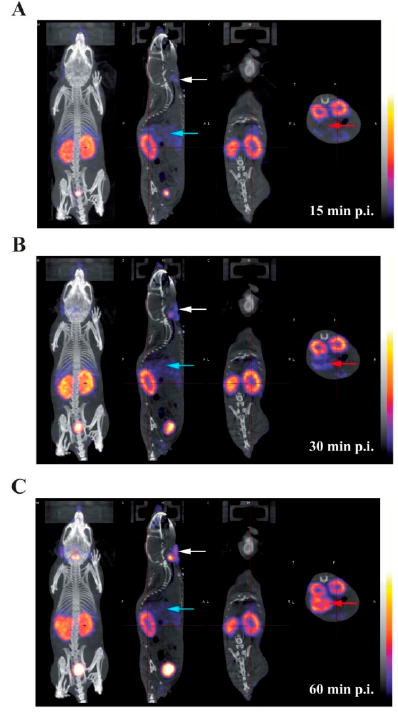
Figure 4. Whole-body SPECT/CT in vivo imaging of 125 I-Tyr-MCa in CD-1 mice at 15 min post-injection ( A ); 30 min post-injection ( B ); and 60 min post-injection ( C ); from left to right, 3D rendering, sagittal, coronal, and transverse views of tracer activity. White, blue and red arrows are respectively pointing at salivary gland, liver, and stomach activity.